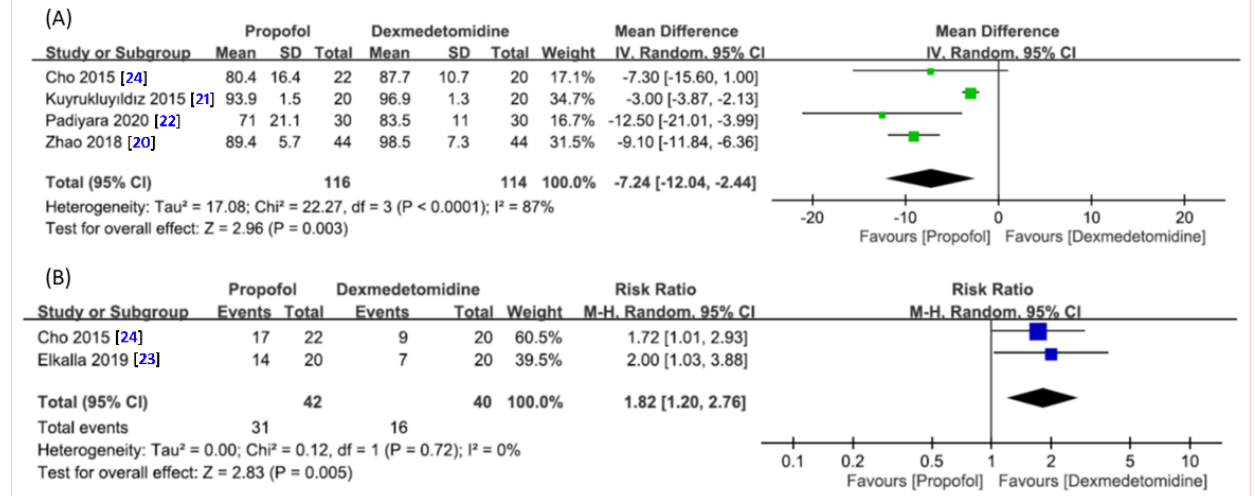
Figure 4. Forest plot for comparing ( A ) the minimum oxygen saturation and ( B ) risk of oxygen desaturation during drug-induced sleep endoscopy between propofol and dexmedetomidine groups. CI, confidence interval; IV, inverse variance; M–H, Mantel–Haenszel.